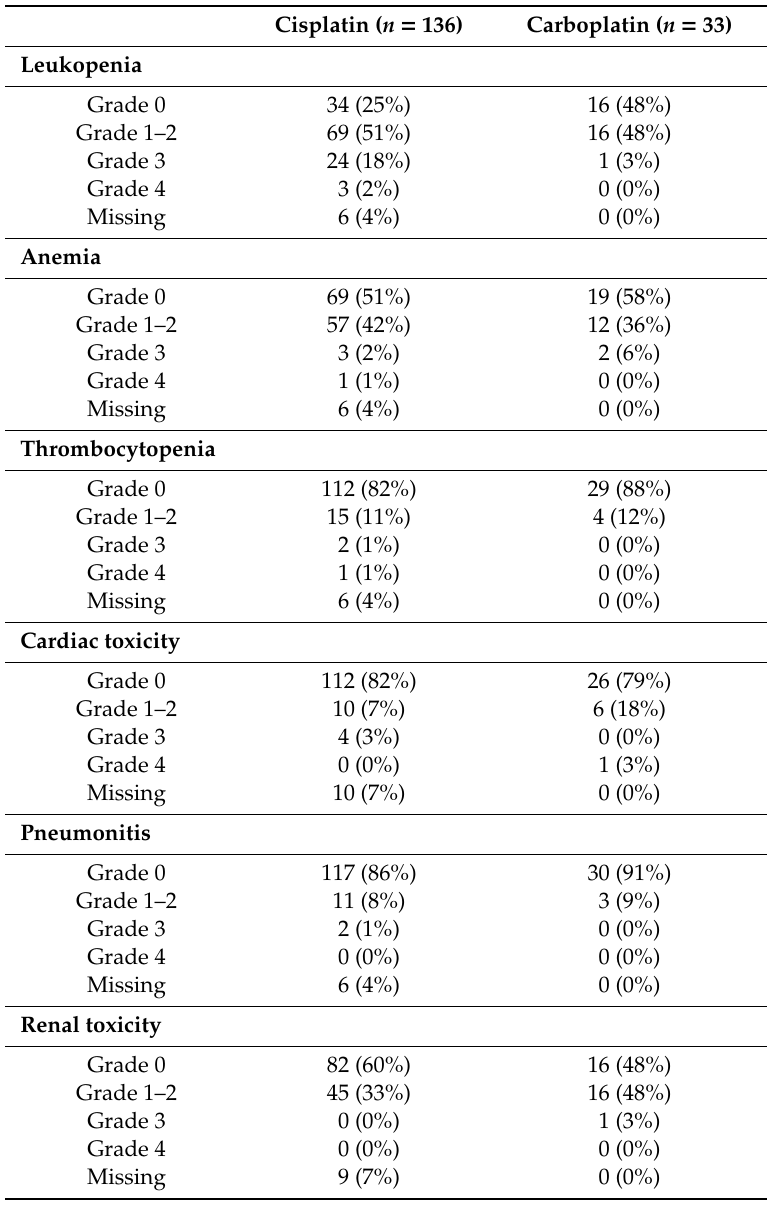
Table 4. Toxicities in patients receiving cisplatin vs.